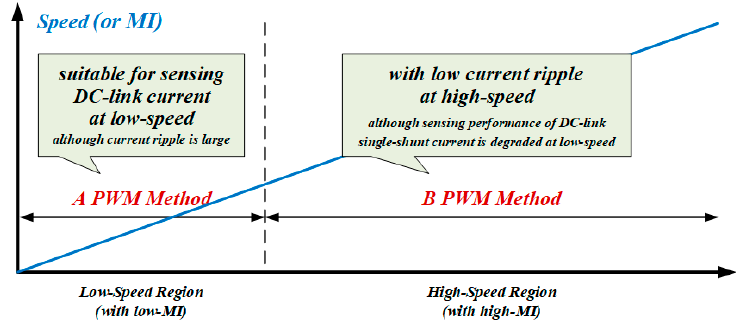
Figure 1. Control strategy using hybrid pulse width modulation (PWM) method according to operation region.